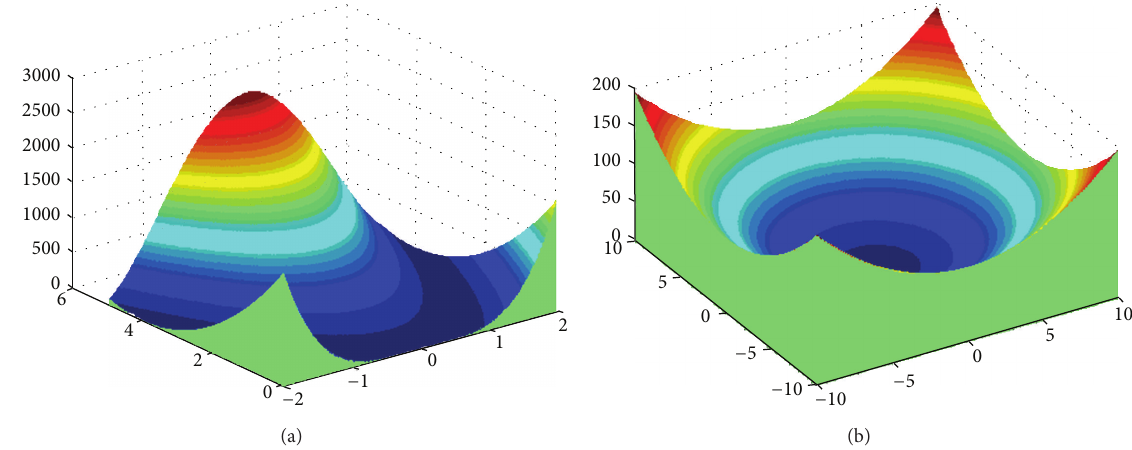
Figure 5: (a) The Rosenbrock function ( 𝑛 = 2 ), (b) the sphere function ( 𝑛 = 2